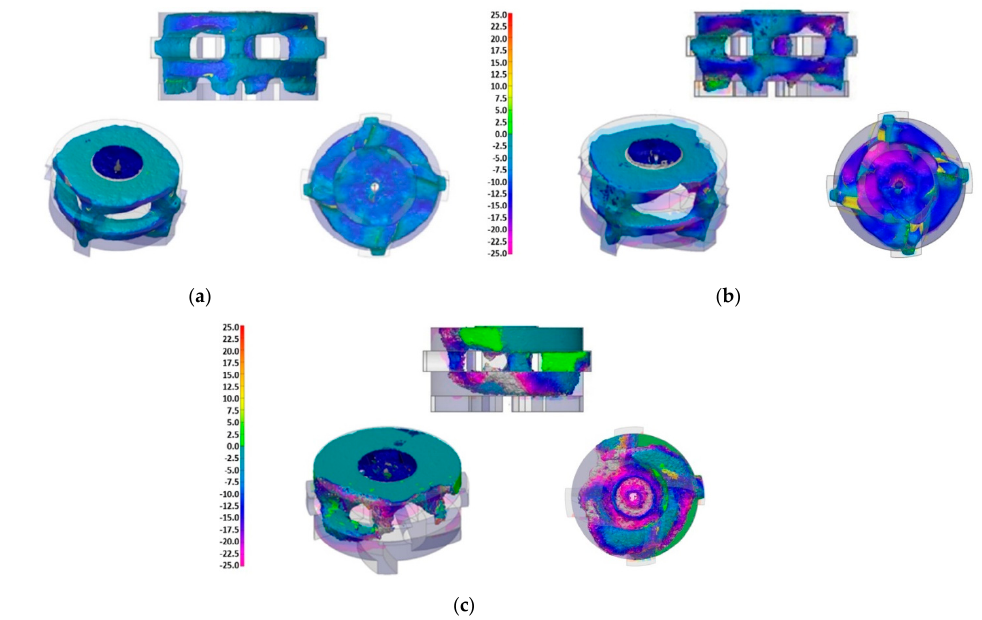
for series 1/VT and 2/VT (0% and 25% wear).